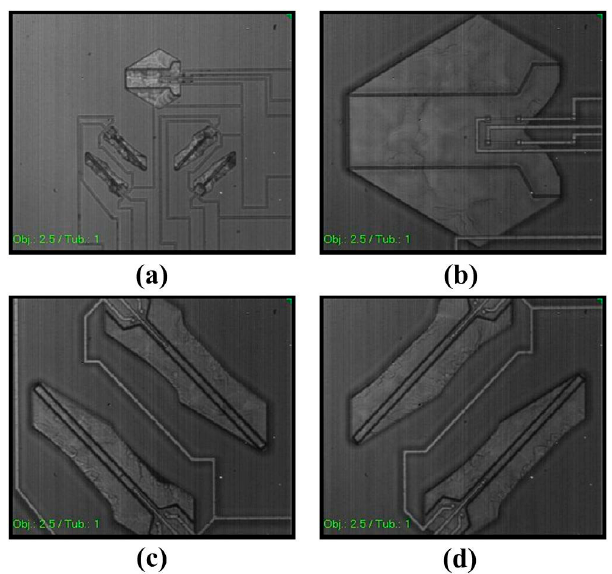
Figure 4. ( a ) infrared microscopic image showing the laterally etched cavities under every cantilever. ( b–d ) Cavities under the Z-cantilever, X-axis cantilevers, and Y-axis cantilevers, respectively. The fabricated tri-axis high-shock accelerometer chip (3.5 mm × 3.5 mm) is showed in the top-view SEM image of Figure 5a. Four narrow cantilevers for X-/Y-axis sensing and one wide cantilever for vertical Z-axis sensing are formed in one chip. There are two aluminum pads used for input voltage and six pads for output voltage of the three axes. The cross section of the fabricated X-/Y-cantilevers